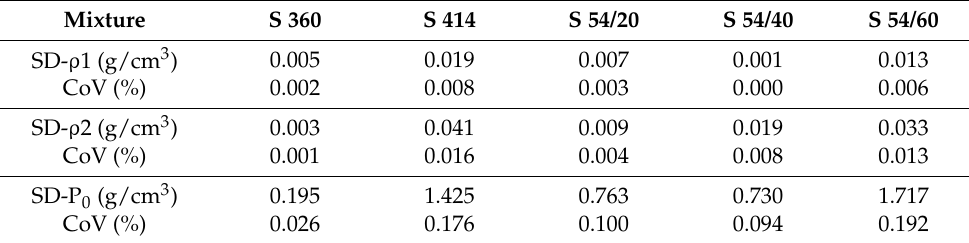
Figure 11. ( a ) Dry density ( ρ 1 ), density after immersion and boiling ( ρ 2 ) and content of permeable pores (P 0 ) at the age of 150 days; ( b ) the relationship between the loss of compressive strength after 300 freeze–thaw cycles ( η 300 ) and the permeable pore content (P 0 ) of the control samples. Table 5. Standard deviation (SD) and coefficient of variation (CoV) calculated for density and permeable pore